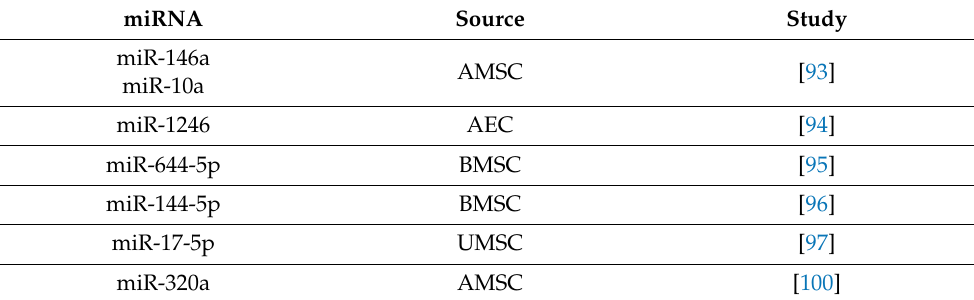
Table 3. The most common exosomal miRNA candidates for POI treatment.